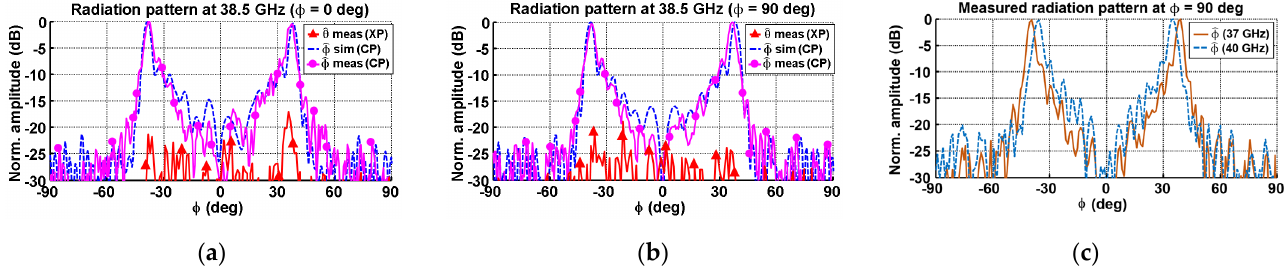
Figure 14. Conformal array antenna normalized radiation patterns: ( a ) simulated and measured ϕ = 0° patterns at 38.5 GHz; ( b ) simulated and measured ϕ = 90° patterns at 38.5 GHz; and ( c ) measured ϕ = 90° patterns at 37 and 40 GHz.